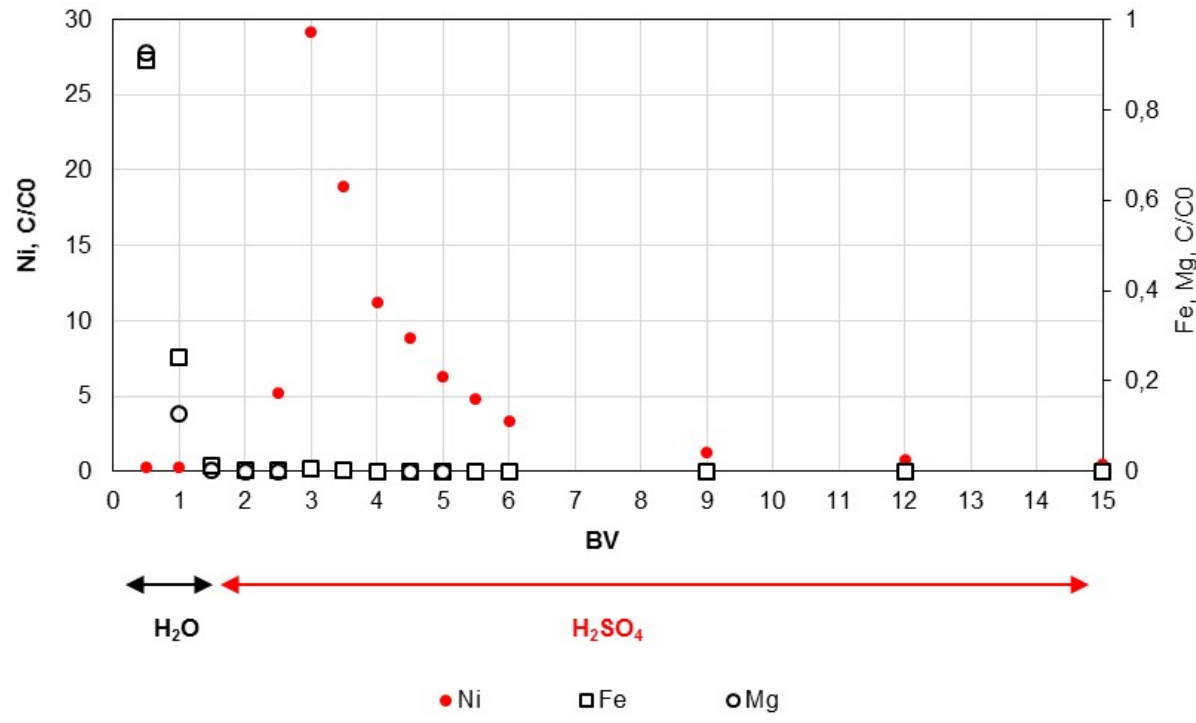
Figure 6: Elution of nickel for solution containing 25 ppm Ni, 2.7 g/L Mg, 0.5 g/L Fe at pH 1.5.